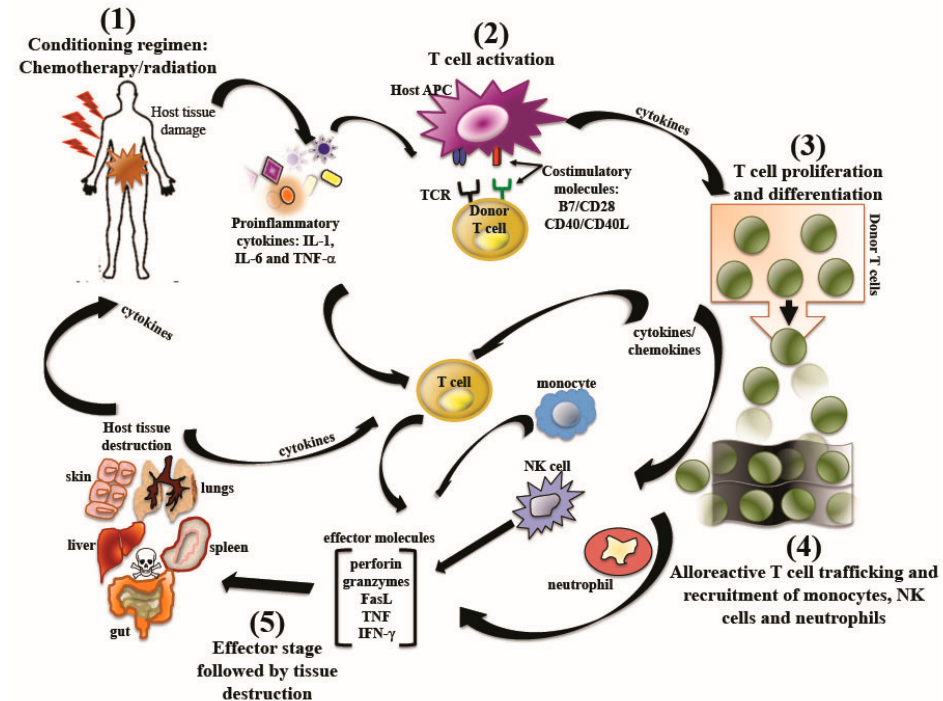
Figure 1. Overview of the pathophysiology of graft- versus -host disease. The pathophysiology of graft -versus -host disease (GVHD) involves five steps. (1) Conditioning regimen with chemotherapy and/or total body irradiation, which results in the release of pro-inflammatory cytokines that affects host-antigen presenting cells (APCs) by increasing their maturation and the expression of co-stimulatory molecules and cytokines, which in turn fuel donor alloreactive T cells. (2) T cell recognition followed by T cell receptor (TCR) ligation, (the first signal to the donor T cells) and engagement of stimulatory molecules (the second signal to the donor T cells). Both of these signals are required for full T cell activation and subsequent expansion. (3) Proliferation and differentiation of alloreactive donor T cells, followed by (4) trafficking of alloreactive T cells toward GVHD target organs (e.g., skin, gut, liver,